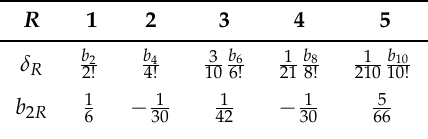
Table 2. Coefficients of the modified differential equations and Bernoulli